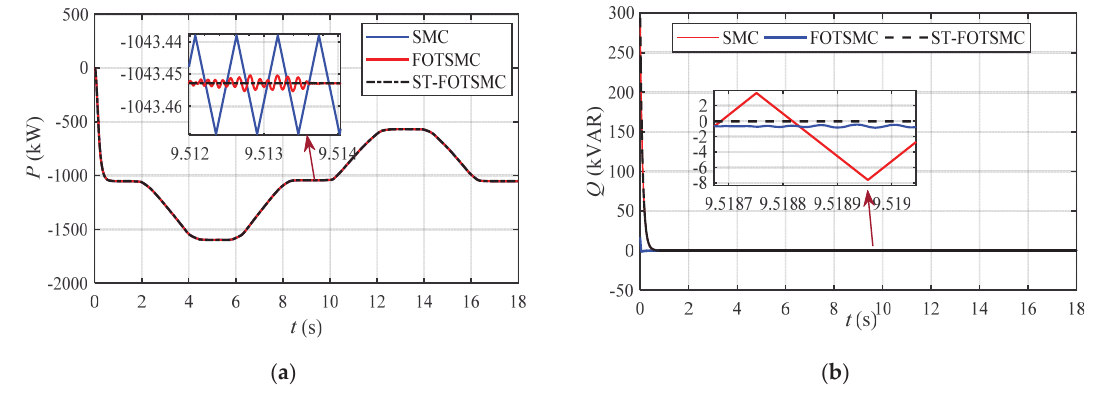
Figure (cid:561) 6. (cid:561) ( a ) (cid:561) Active (cid:561) power (cid:561) comparison; (cid:561) ( b ) (cid:561) reactive (cid:561) power (cid:561) comparison. (cid:561) Figure 6. ( a ) Active power comparison; ( b ) reactive power